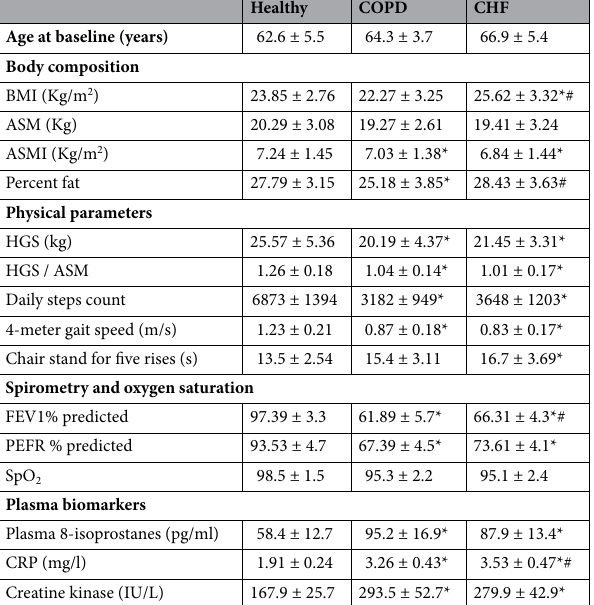
Table 1. Body composition, physical parameters and circulating biomarkers in healthy controls and patients with COPD and CHF. Values are expressed as mean ± SD, one-way analysis of variance. * p < 0.05 vs. healthy controls; # p < 0.05 vs. COPD participants; (N = 83–88/group). (BMI; body mass index, ASM; appendicular skeletal mass, ASMI; appendicular skeletal mass index, HGS; hand-grip strength, FEV1; forced expiratory volume in 1 s, PEFR; peak expiratory flow rate, CRP; C—reactive